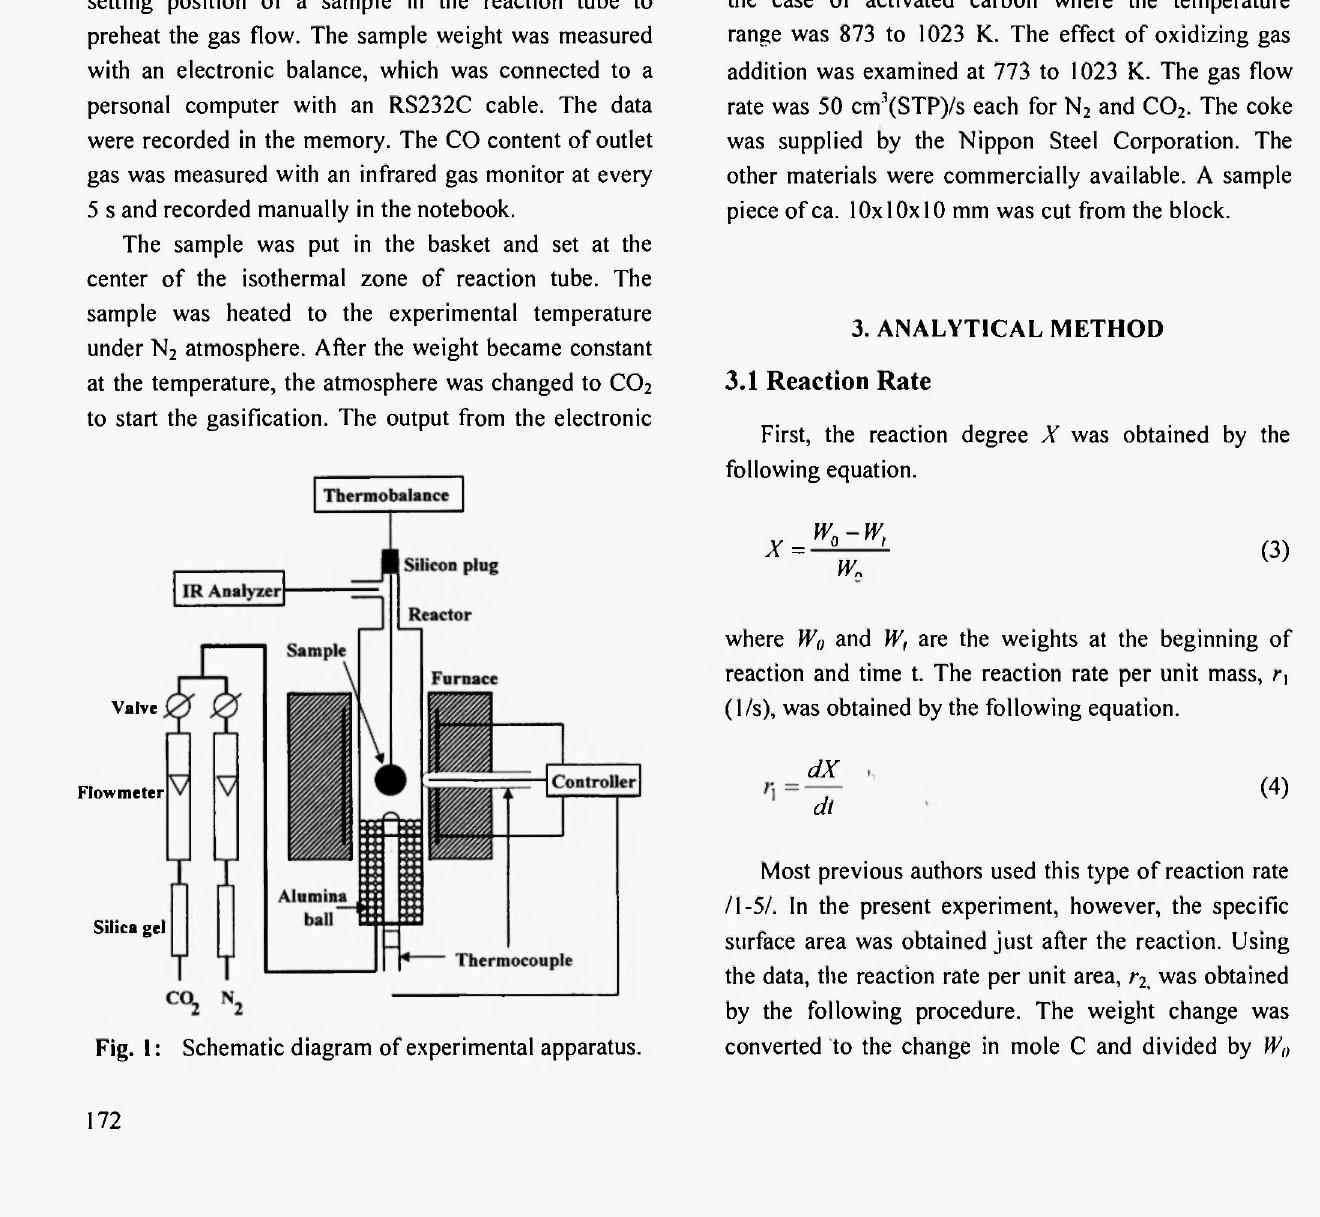
Fig. I: Schematic diagram of experimental